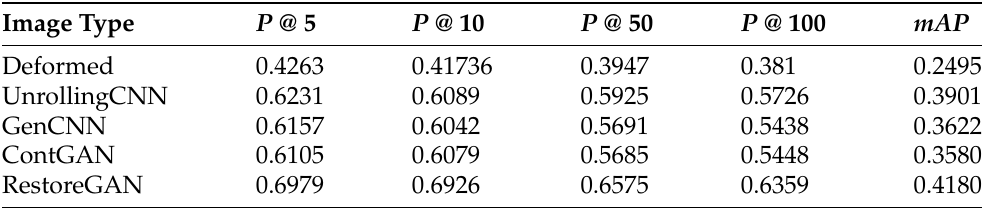
Table 1. Image retrieval results by ResNet50 on deformed and restored images from